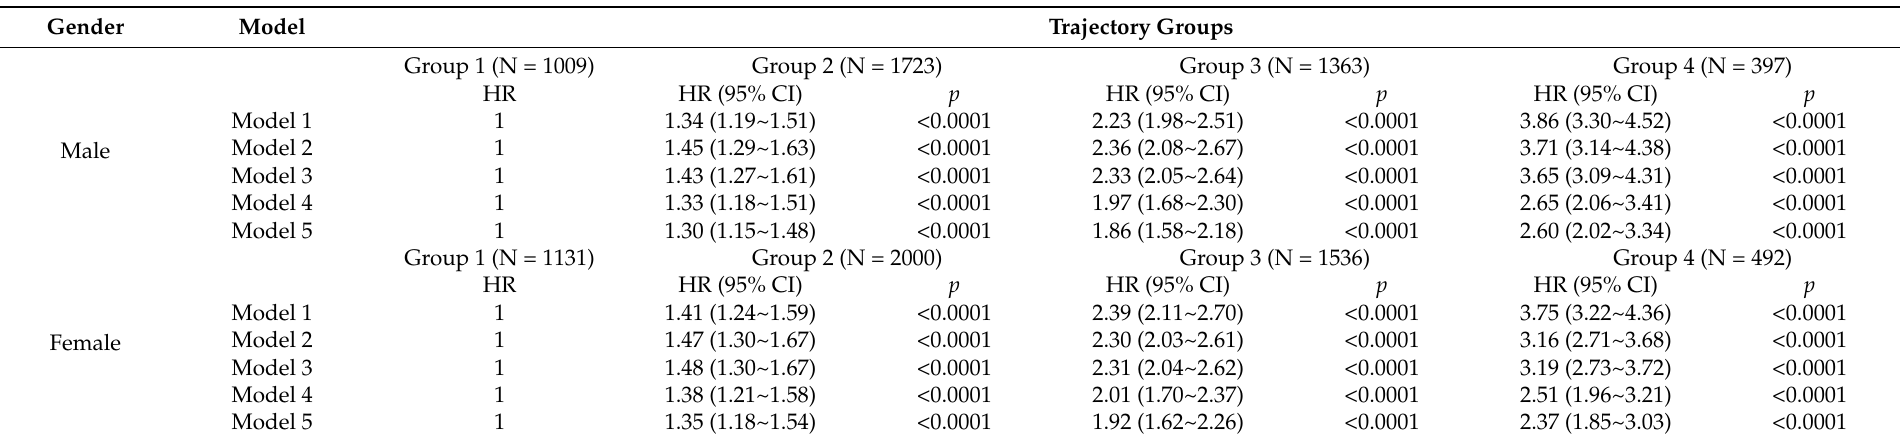
Table 2. Associations between multiple trajectories and risks of hypertension by